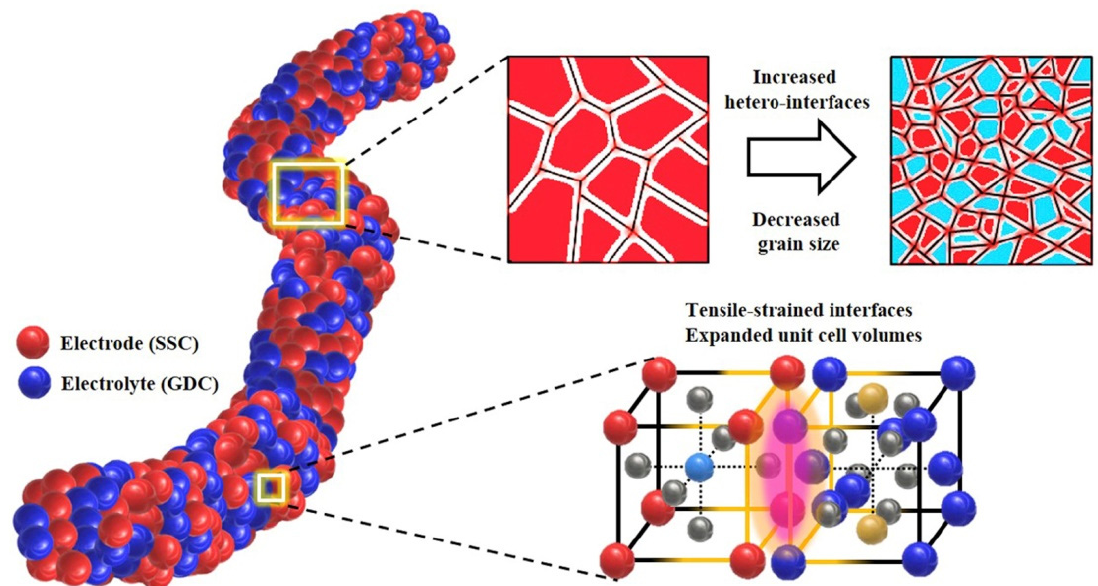
Figure 6. Schematic of electrode/electrolyte nanofiber from Sm 0.5 Sr 0.5 CoO 3 − δ (SSC) and Gd 0.2 Ce 0.8 O 1.9 (GDC) with increased hetero-interface, decreased grain size, and expanded unit cell volumes. Reprinted from [195], with permission from Elsevier.